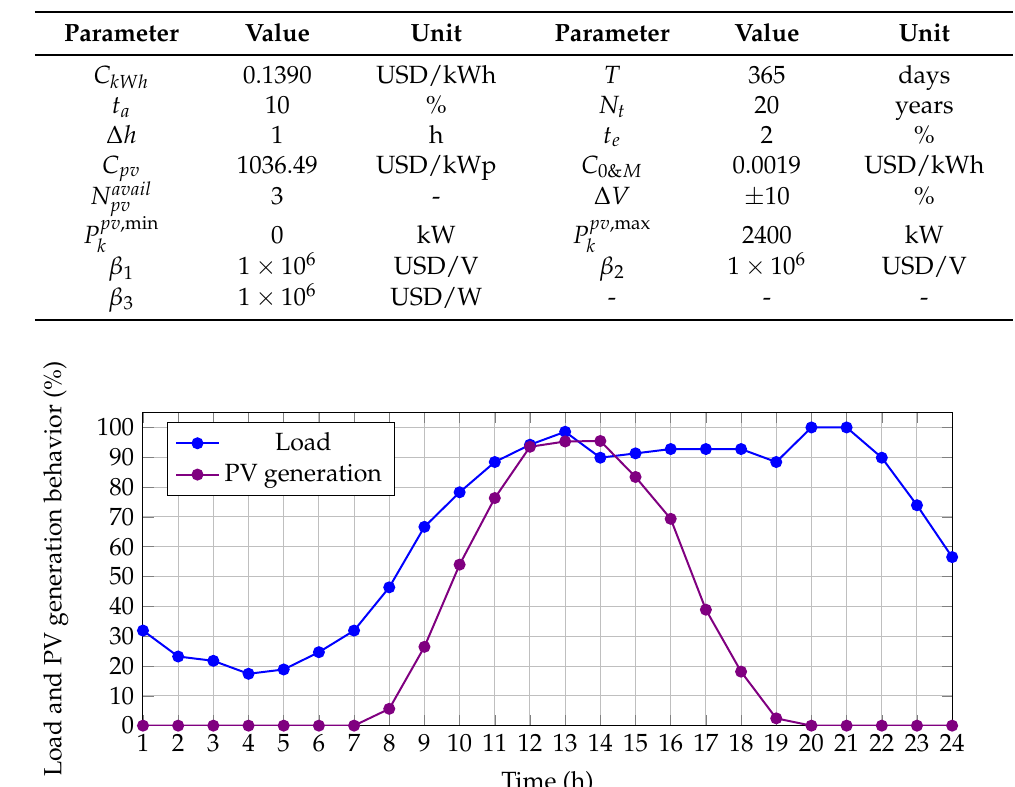
Figure 2. Single-line diagram of the two test feeders used in this study: ( a ) 33-node test system and ( b ) 69-node test system. Table 1. Parameters used to calculate the objective function.